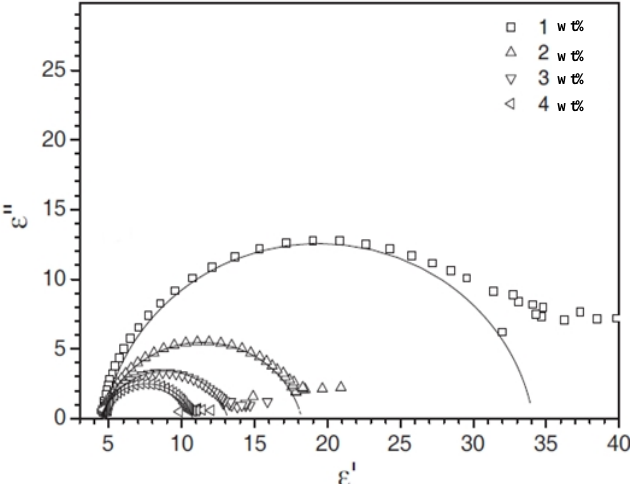
Figure 10. Cole-Cole plot, ε′′ versus ε′ , of the dielectric properties for varying polymer network concentration. (Reproduced with permission from [58]. Copyright 2009 EDP Sciences).